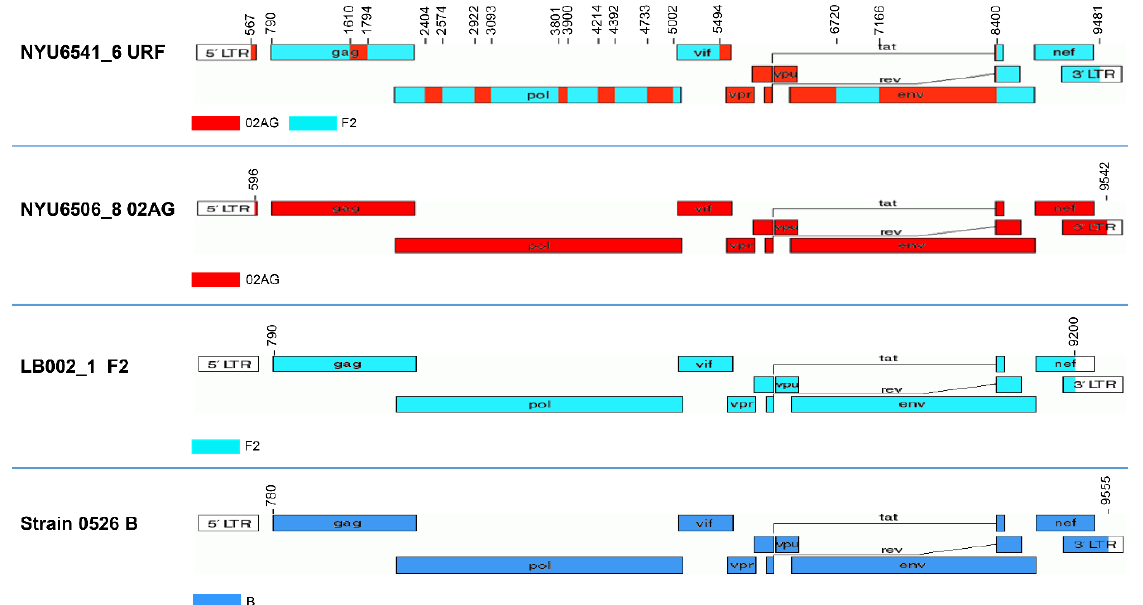
Figure 4. Development of a near full genome sequencing approach using recombinant and pure subtype strains. Genome maps of four HIV-1 strains, which were used to develop the near full genome sequencing approach. The determined subtypes are indicated using the recombinant drawing tool of the LANL database. NYU6541_6, NYU6506_8, LB002_1 and strain 0526 correspond to a unique recombinant form (URF), the circulating recombinant form CRF02_AG, sub-subtype F2, and subtype B, respectively.